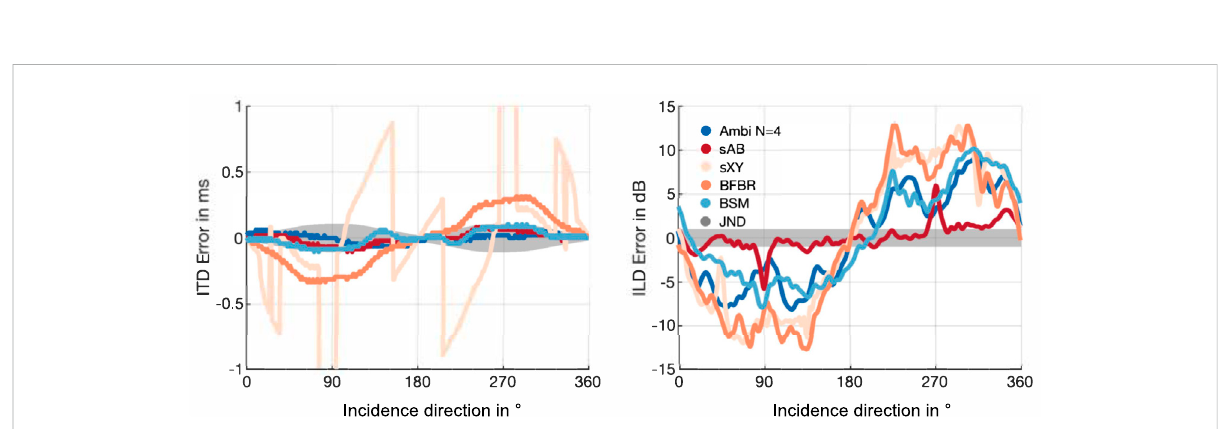
FIGURE 7 ITD and ILD errors for the EMA8 array using different binaural reproduction approaches. The shaded gray areas represent JNDs.